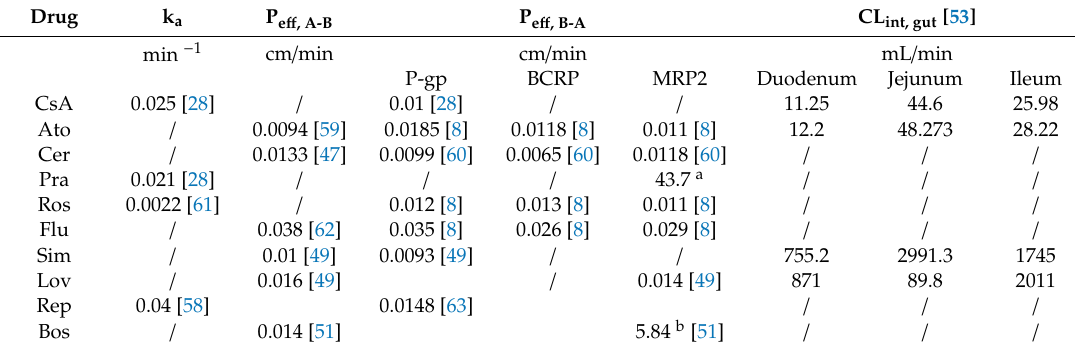
Table 4. Intrinsic metabolic / transport parameters of cyclosporin A (CsA), atorvastatin (Ato), cerivastatin (Cer), pravastatin (Pra), rosuvastatin (Ros), fluvastatin (Flu), simvastatin (Sim), lovastatin (Lov), repaglinide (Rep) and bosentan (Bos) in the